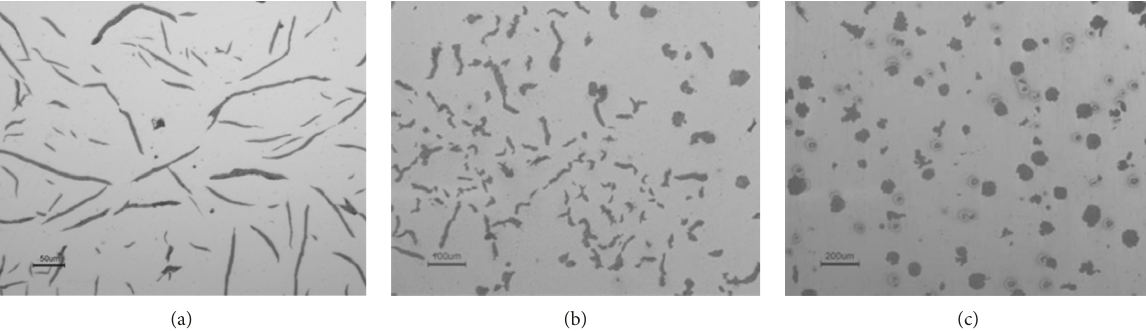
Figure 1: Microstructure of cast iron: (a) grey iron; (b) compacted graphite iron; (c) nodular graphite iron.